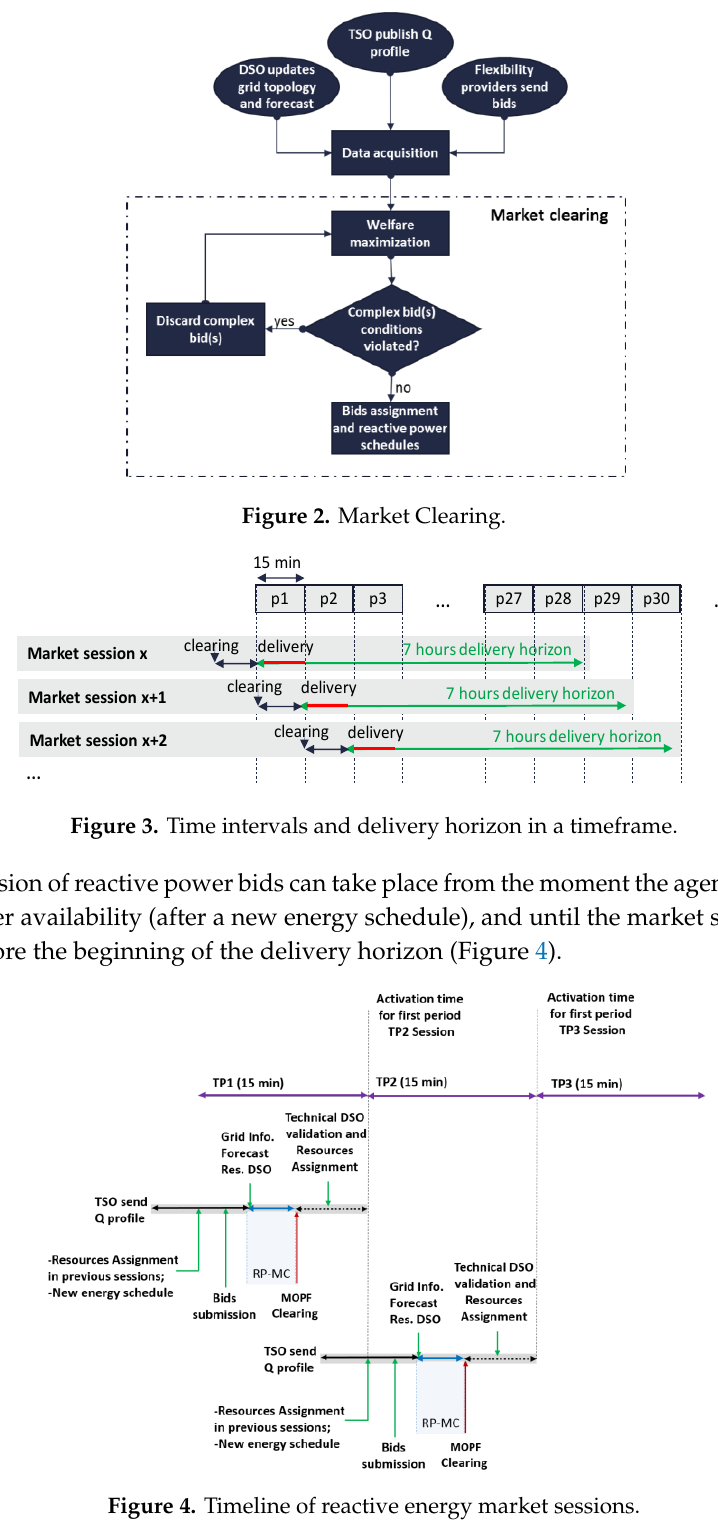
Figure 4. Timeline of reactive energy market sessions.